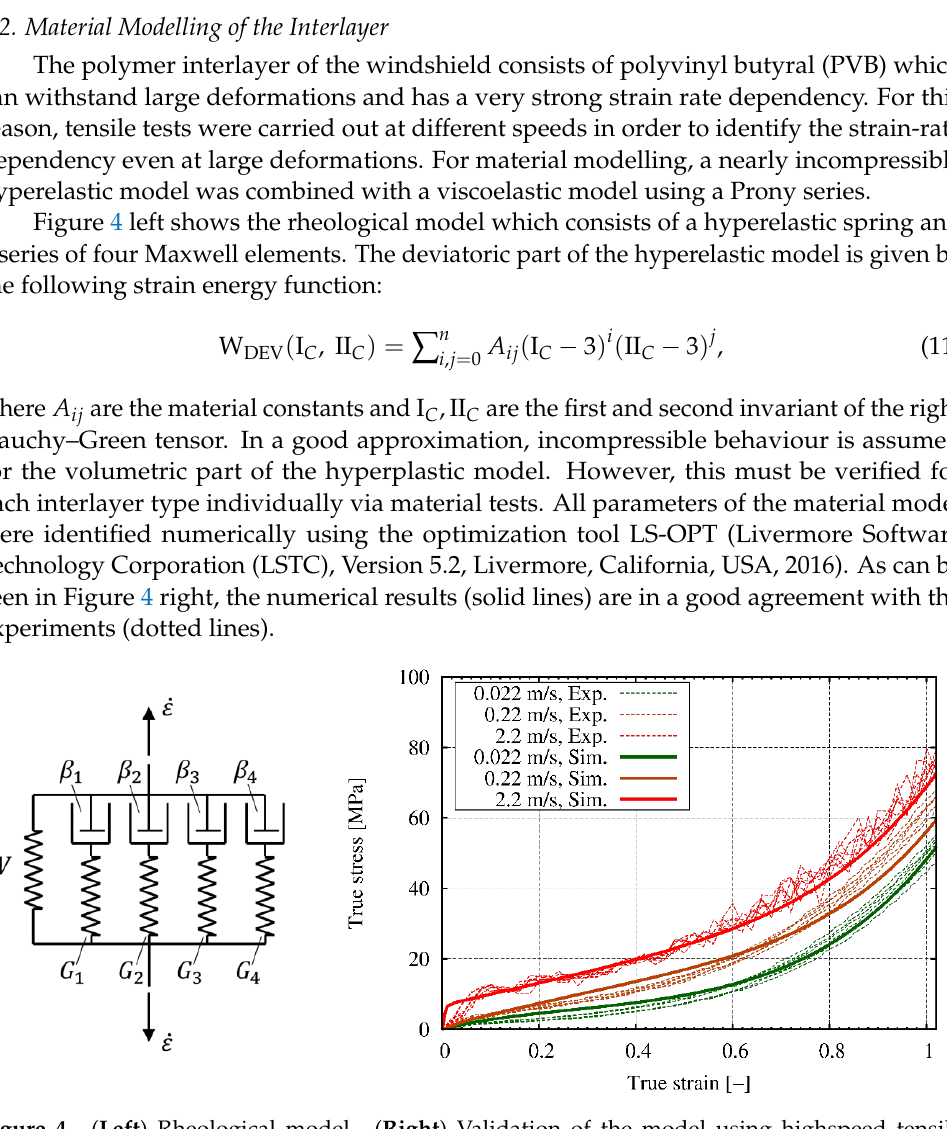
Figure 4. ( Left ) Rheological model. ( Right ) Validation of the model using highspeed tensile tests, cf. [10].